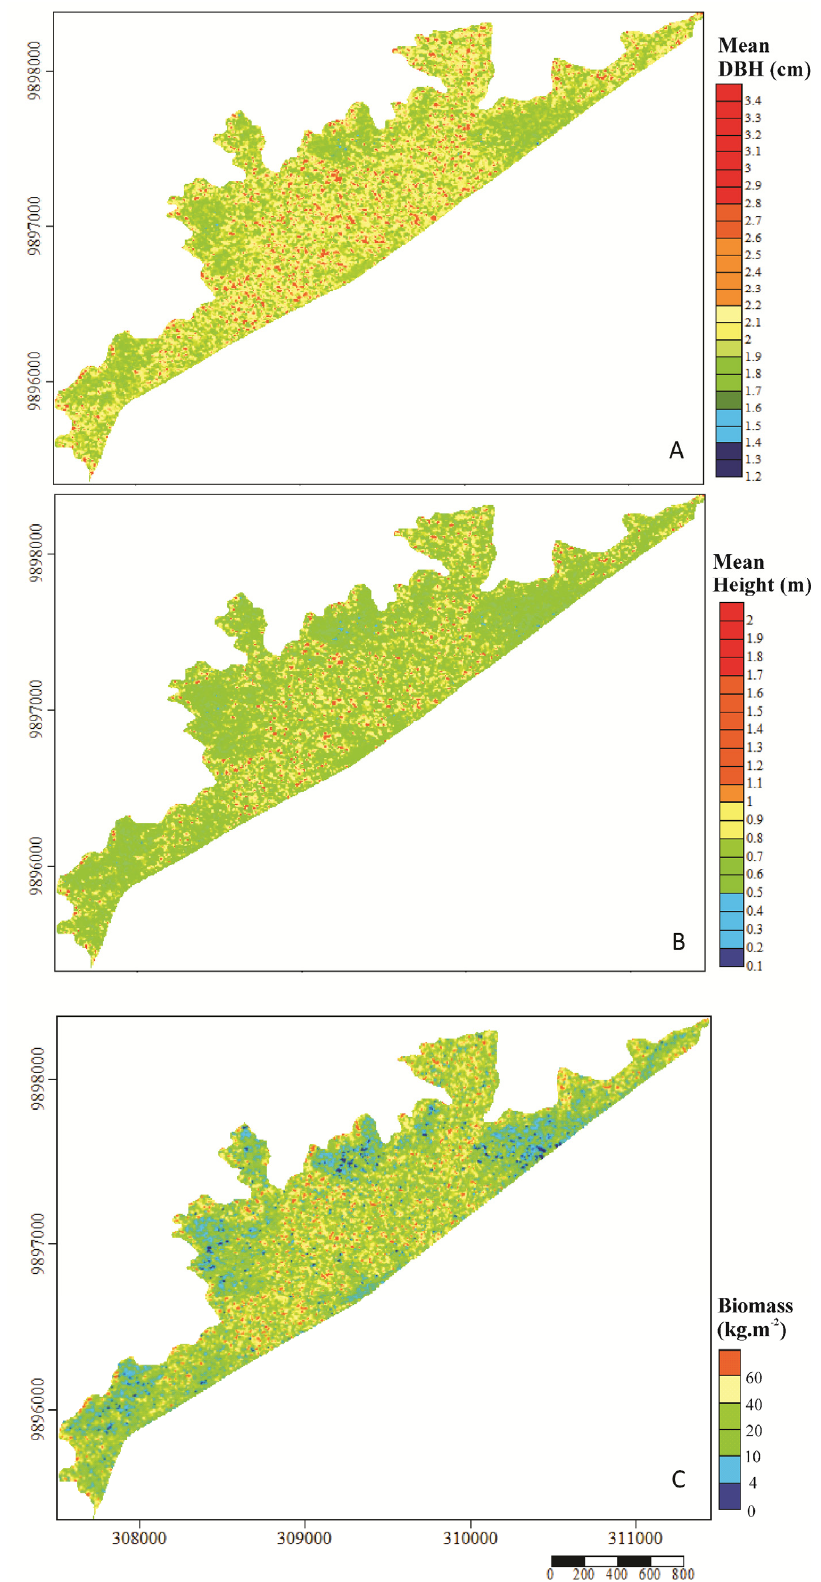
Figure 5. Estimation map: ( A ) average DBH (cm) and ( B ) average height (m) and ( C ) total biomass (kg·m − 2 ) based on the backscattering values through their multiple regression functions.